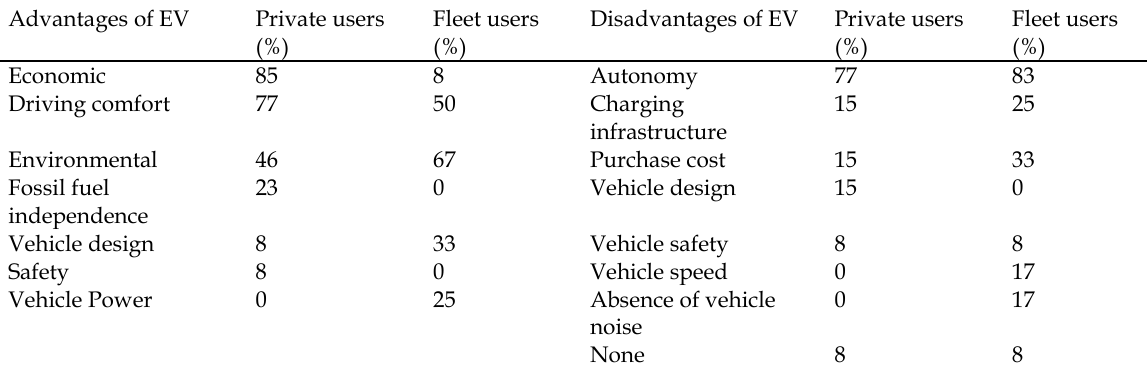
Table 3 EV advantages and disadvantages according to private and fleet users (percentage of